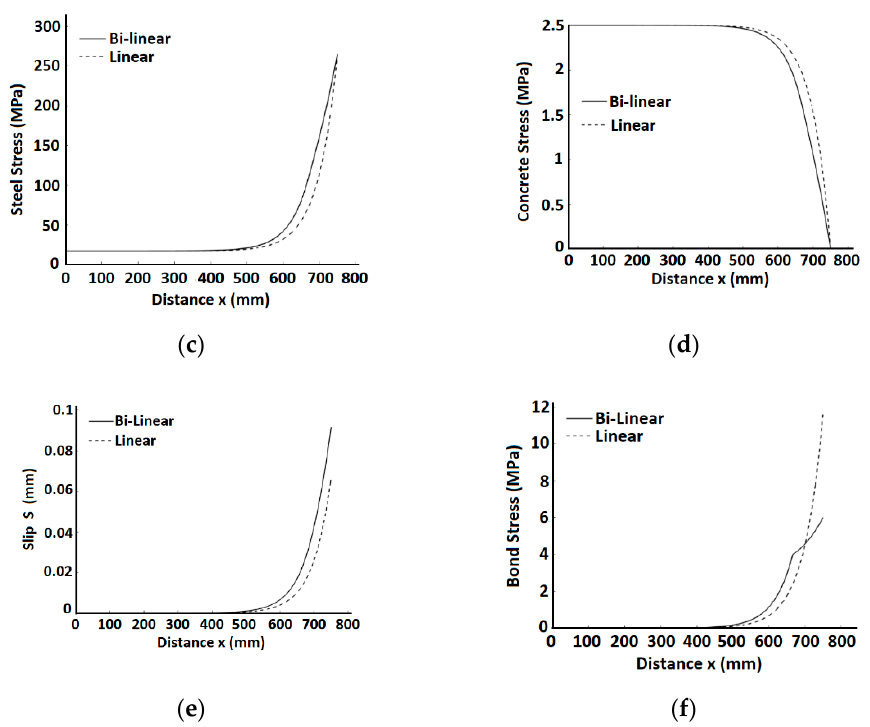
Figure 6. Displacements, slip, and stress distributions along the element half-length. ( a ) rebar displacement; ( b ) concrete displacement; ( c ) rebar stress, ( d ) concrete stress; ( e ) slip; ( f ) bond stress.